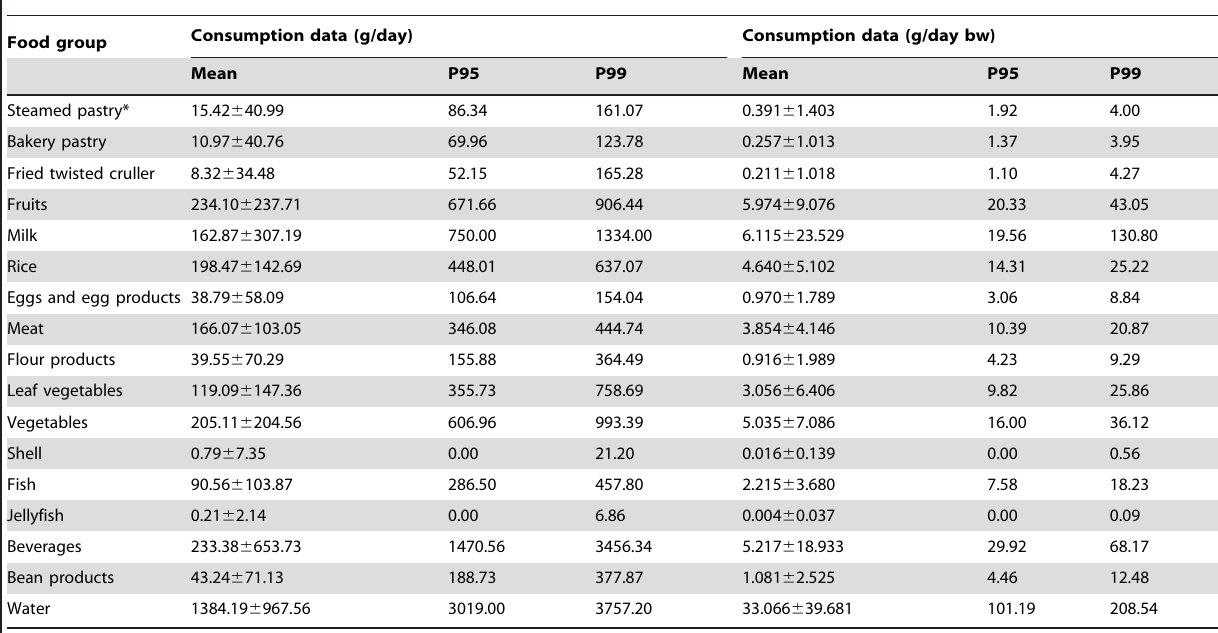
Table 1. Food consumption data (mean, 95th and 99th percentiles) of the Shenzhen population.